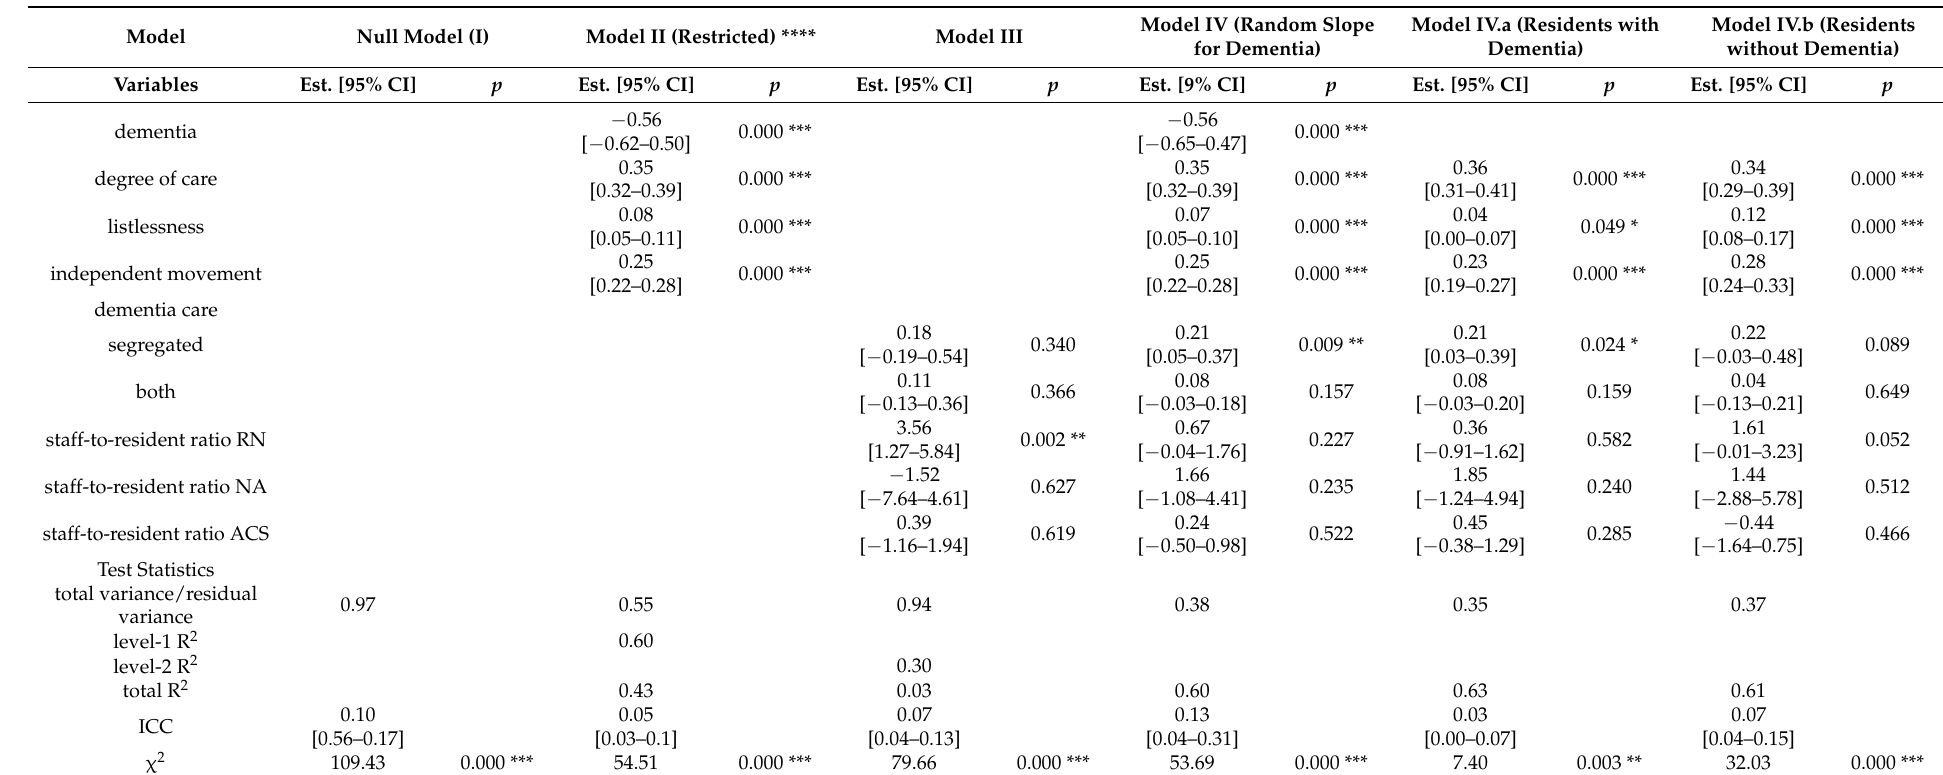
Table 3. Regression